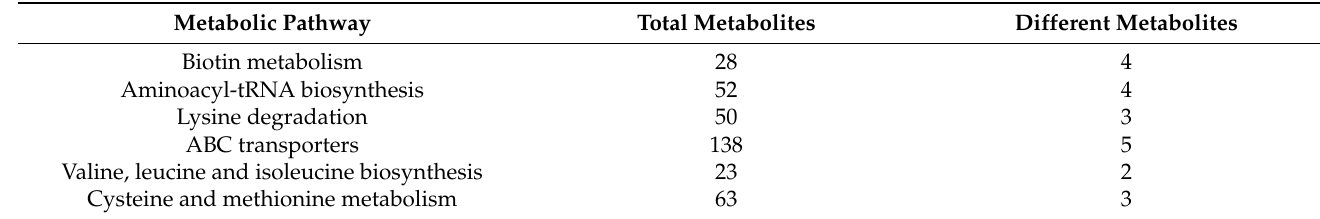
Table 9. Pathways of KEGG enrichment of different metabolites in leg